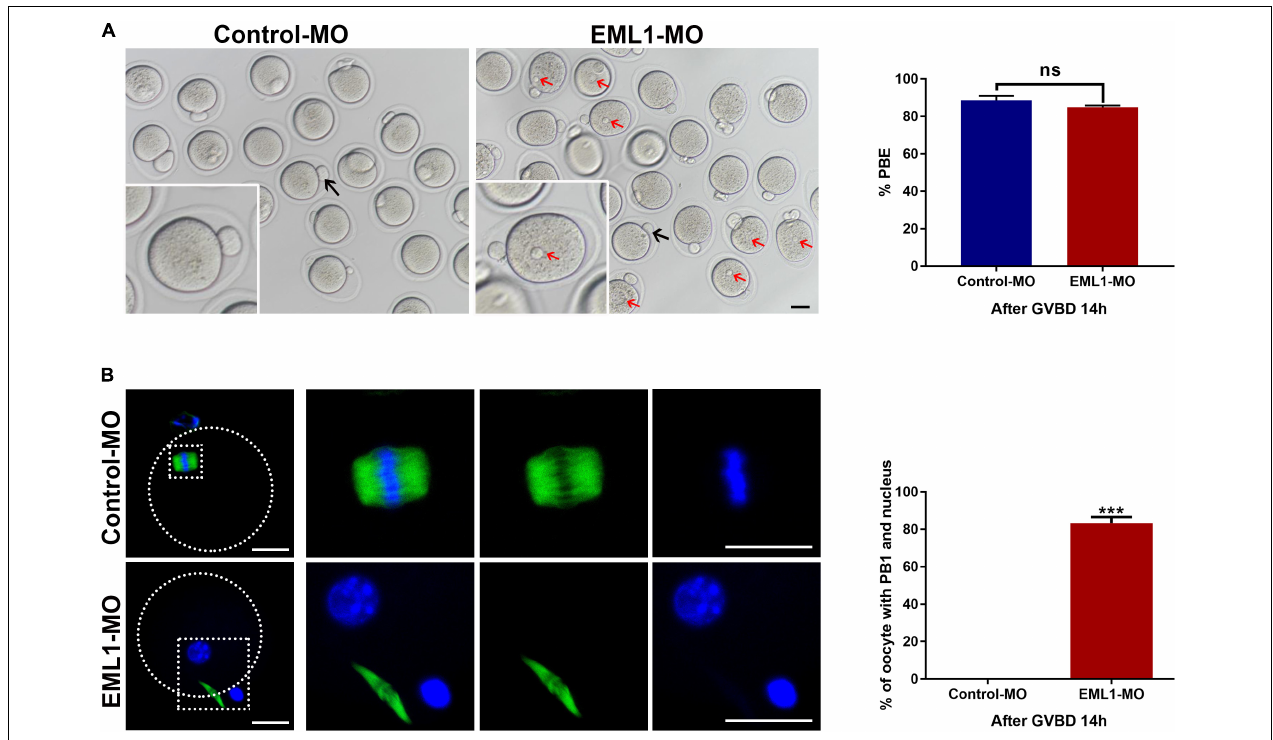
FIGURE 7 | Knockdown of EML1 causes the spontaneous formation of pronucleus and failure to enter into the second metaphase by the matured oocytes after completion of the first meiotic division. Oocytes microinjected with Control-MO and EML1-MO were first maintained at GV stage for 24 h, and then transferred to maturation medium to allow for IVM. Oocytes that had undergone GVB within 2 h of IVM were selected and further cultured for additional 14 h. At the end of the culture, PBE and formation of pronucleus in oocytes were assessed. (A) Scoring PBE in cultured oocyte under light microscope. Representative bright field images of cultured oocytes are shown in the left panel, and the quantification of the rate of PBE are shown in the right bar graph. Red arrows denote pronucleus (PN), black arrows indicate PB1. Scale Bar = 10 µ m. ns: non-significant. (B) Examining the formation of PN by fluorescent staining of tubulin (green) and DNA (blue) in the matured oocytes. The left panel is the representative images of the stained oocytes, with the magnified view of the circled area are listed on the right side. The right bar graph shows the quantification of the percentage of oocytes that have both the emitted PB1 and the PN. Scale Bar = 20 µ m. *** P < 0.005, compared with the Control-MO group. ns denote no significant difference between the two groups